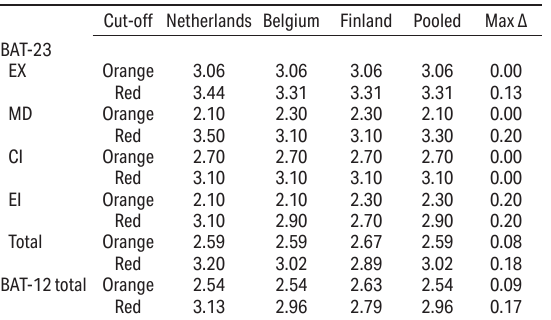
Table 3. Cut-off values for the Burnout Assessment Tool (BAT) and its subscales [EX=exhaustion; MD=mental distance; CI=cognitive im- pairment; EI=emotional impairment]. Note : A table of all operating characteristics (sensitivity, specificity, 1-specificity and Youden-index for each BAT score) is available upon request from the first author.